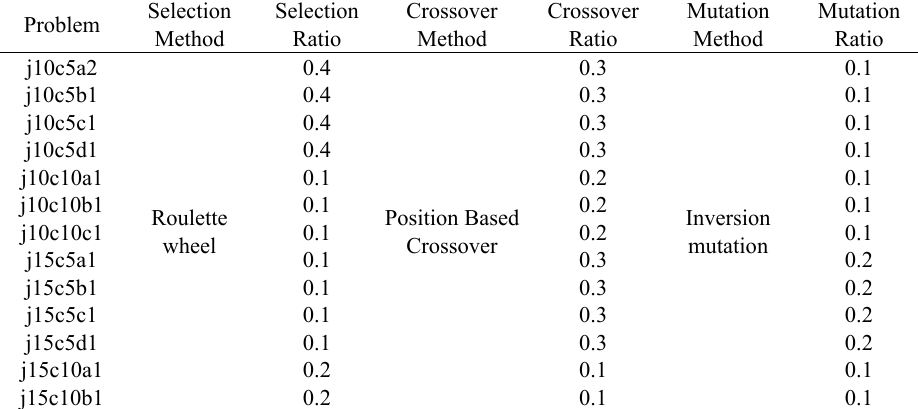
Table 3. The best parameters sets of 13 benchmark